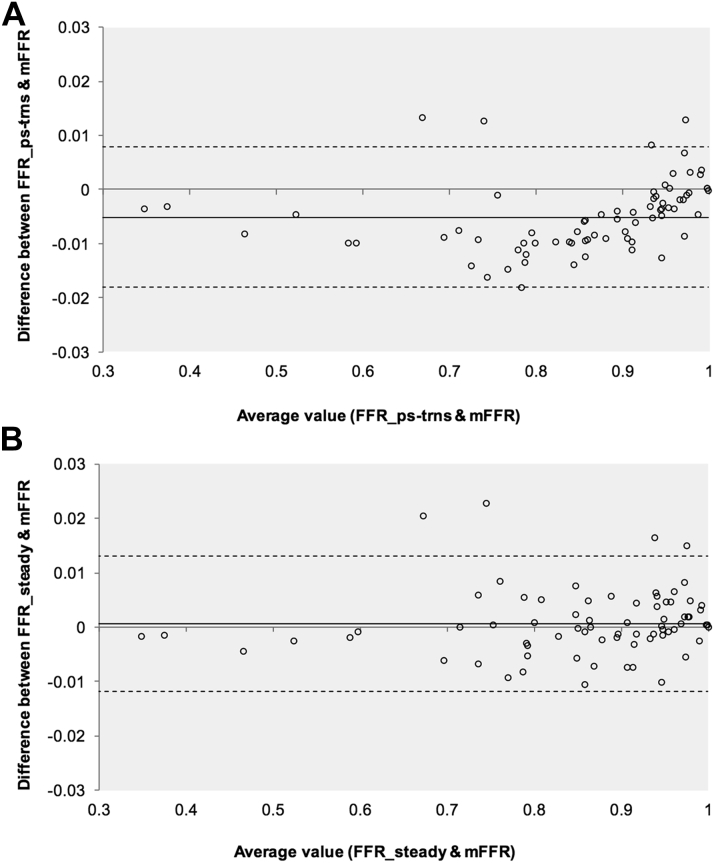
Bland-Altman Plots Demonstrating Agreement Between vFFR and Measured FFRThe solid line indicates bias (mean delta), and the interrupted lines represent the upper and lower limits of agreement (SD: ±1.96). (A) Agreement for vFFRps-trns, and (B) agreement for vFFRsteady. Note the high number of cases in the clinically important FFR range from 0.7 to 0.9.